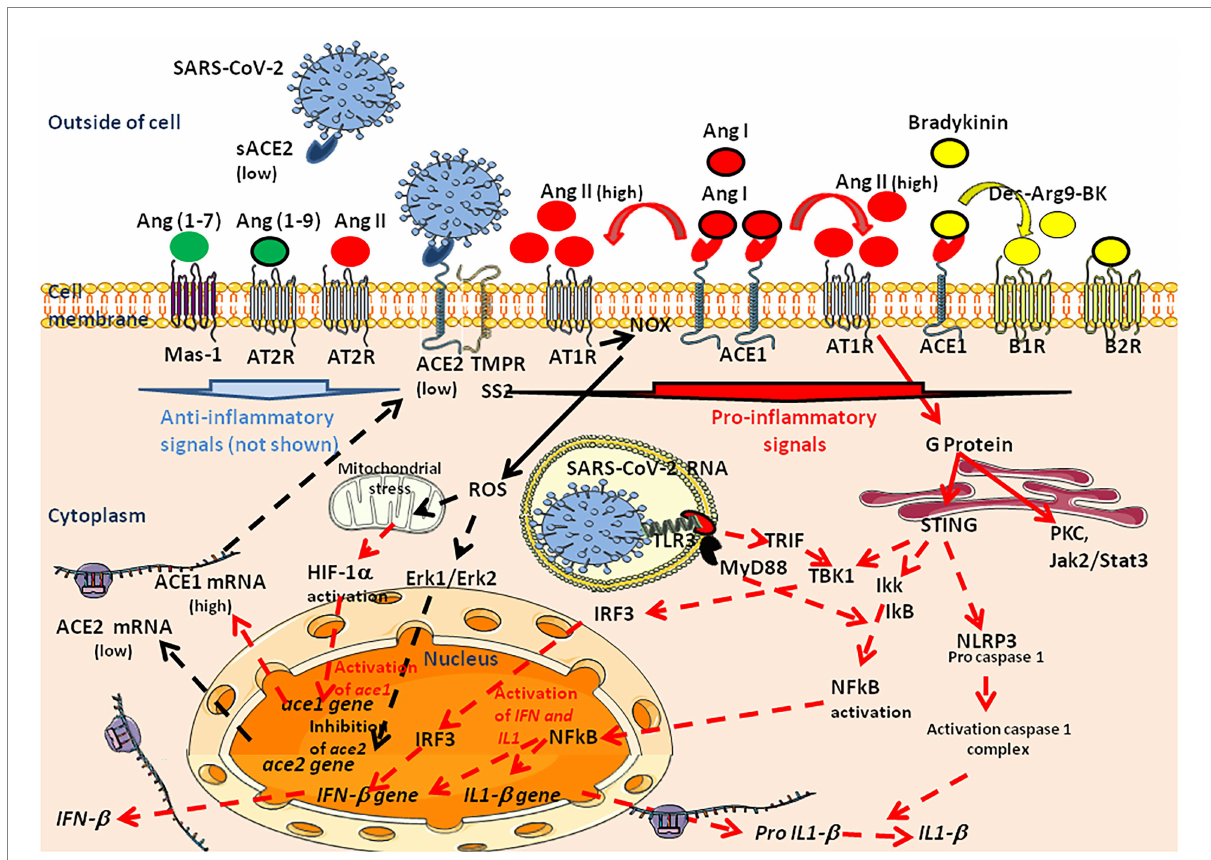
FIGURE 9 Signaling pathways that are activated during SARS-CoV-2 infection and replication. SARS-CoV-2 infects human cells expressing the ACE2 receptor and the serine protease TMPRSS2. This process results in the downregulation of ACE2 mRNA expression, the reduced expression of mACE2, dysfunction of the RAS and increasing levels of AngII in the circulation. High Ang II levels trigger signaling through AT1R. This activates a number of signaling pathways, such as G protein–mediated (Gq and Gi), Janus kinase/signal transducers and activators of transcription, extracellular signal- regulated kinase (ERK), IFN regulatory factor (IRF)3, NF- κ B, NLRP3 procaspase 1 pathways leading to induction of IFNs and pro-inflammatory cytokines, and the HIF-1 α pathway. In addition, G protein–independent signaling takes place through the adapter proteins β -arrestin 1 and β -arrestin 2 that can have distinct functional and physiological consequences (not shown). Crosstalk between AT1R and AT2R was evidenced and stimulation of one receptor modulates the expression of the other. Ang II can bind both to AT1R and AT2R, which are receptors with opposite effects but the low expression of AT2R compared to AT1R, account for a privilegied effect of Ang II through AT1R when the plasma levels of Ang II increase. The single AT1R gene in humans encodes a 359-amino-acid protein and AT1R is widely expressed and well conserved between species The MAS receptor can interact with AT1R, explaining that it is the physiological antagonist of Ang II signaling. Mas1 activation induces the second- messenger cAMP, phospholipase A2 pathway, and the phosphoinositide 3-kinase/AKT pathway, and mediates antiapoptotic, anti-inflammatory, vasodilatory, and antithrombotic effects. Excess of Ang II results in organ damage, hypertension, thrombotic microangiopathy, progression to fibrosis, and cardiovascular